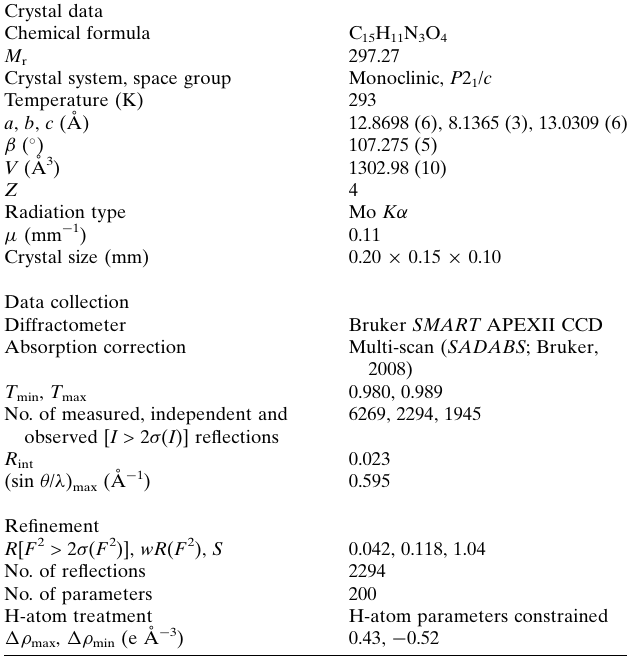
Table 2 Experimental